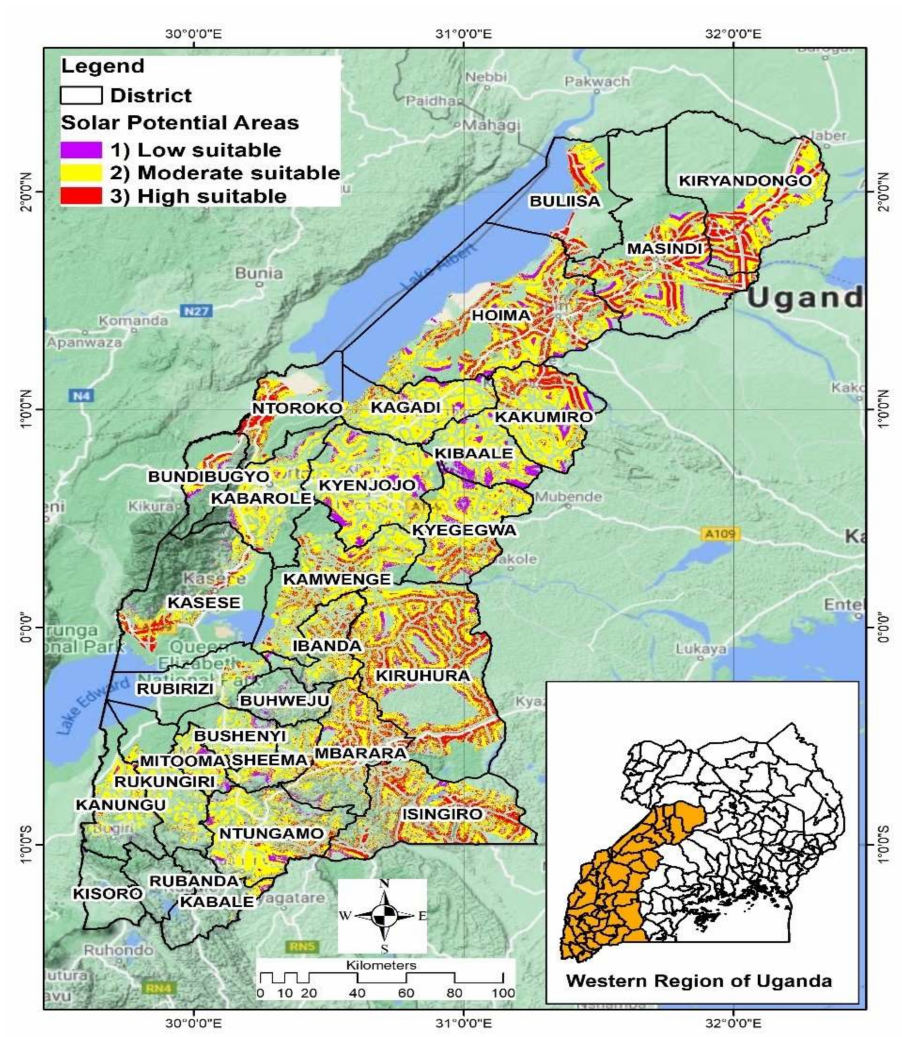
Figure 16. Map showing solar potential areas in the study area.